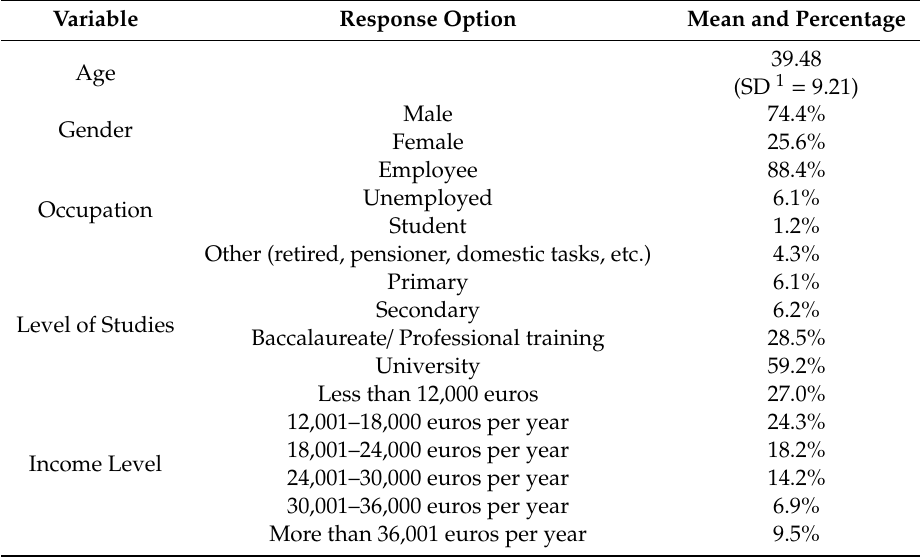
Table 1. Sociodemographic characteristics of the